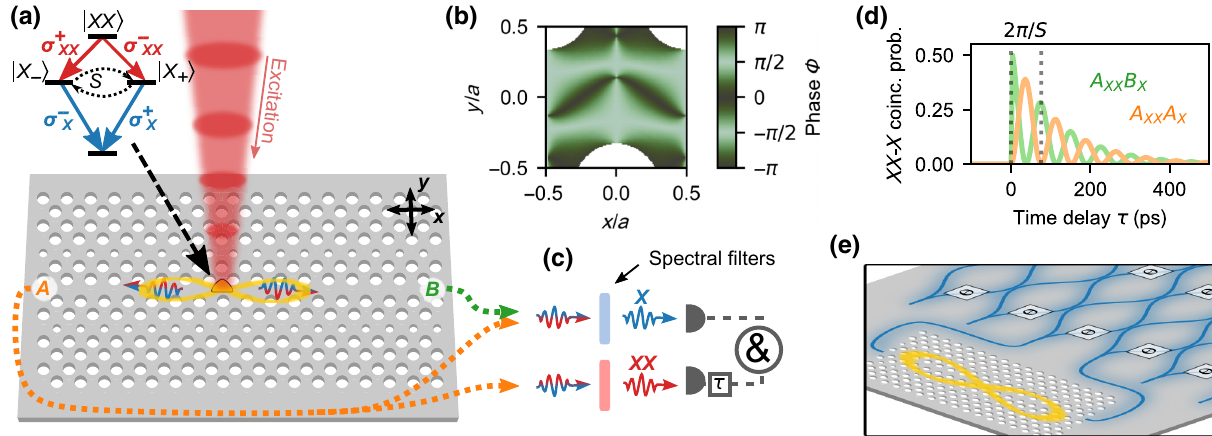
FIG. 1. Operational principle of spatial dual-rail entanglement source in a planar photonic circuit. (a) Illustration of the device containing a QD in a glide-plane waveguide (GPW). The QD is optically excited to the biexciton state ( XX ) that recombines through a cascaded decay (level structure in inset) via the exciton states ( X ± ) emitting a circularly polarized entangled photon pair. In the GPW, circular-polarized photons with opposite helicity couples preferentially to only one of the directions, i.e., A or B , which enables path entanglement generation. A nonzero fine-structure splitting S induces temporal spin-flip oscillations between the exciton states, as illustrated in the inset. (b) Calculated local phase (cid:5) between the E x and E y components of the electric field at different spatial locations within the unit cell of the GPW. (cid:5) = ± π/ 2 correspond to the locations of ideal chiral coupling. Here, a is the lattice parameter of the photonic crystal. (c) Experimental setup for projective exciton-biexciton cross-correlation measurements. Two sets of cross-correlation measurements along the same path ( A XX A X ) and different paths ( A XX B X ) are performed. If the photons are collected from the same path, we split the signal using a 50:50 fiber beam splitter as illustrated with the orange dashed line. (d) Predicted two-photon cross- correlation dynamics (coincidence detection probability) for the experimental parameters of S = 2 π × 13 GHz and exciton radiative decay rate γ X = 8.35 ns − 1 and assuming ideal chiral coupling (cid:5) = ± π/ 2. For details on the model see Sec. S5 within the Supplemental Material [21]. The experimental “tell tale” of path correlation is the phase offset of 2 (cid:5) between the ( A XX A X ) and ( A XX B X ) correlation measurements. (e) Proposed integration of a waveguide spatial dual-rail entanglement source into an advanced photonic integrated circuit with phase shifters ( θ ) and beam splitters for quantum-information processing